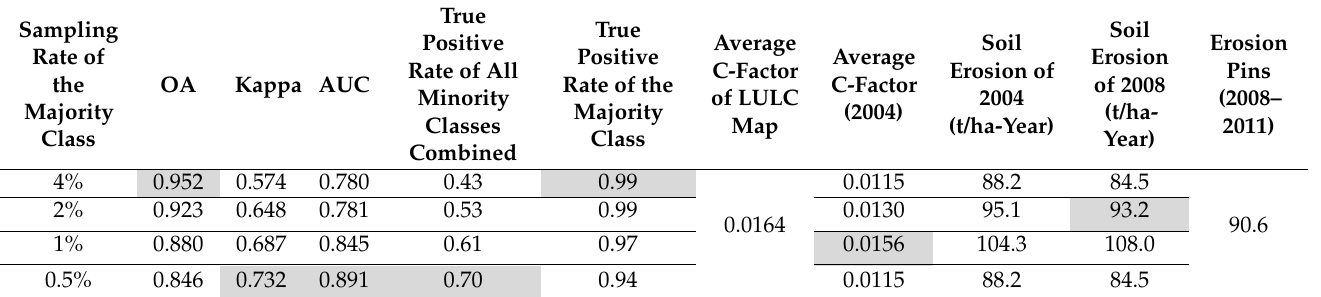
Table 11. Comparison of typical metrics under different sampling rates of the majority class (C = 0.01 class).